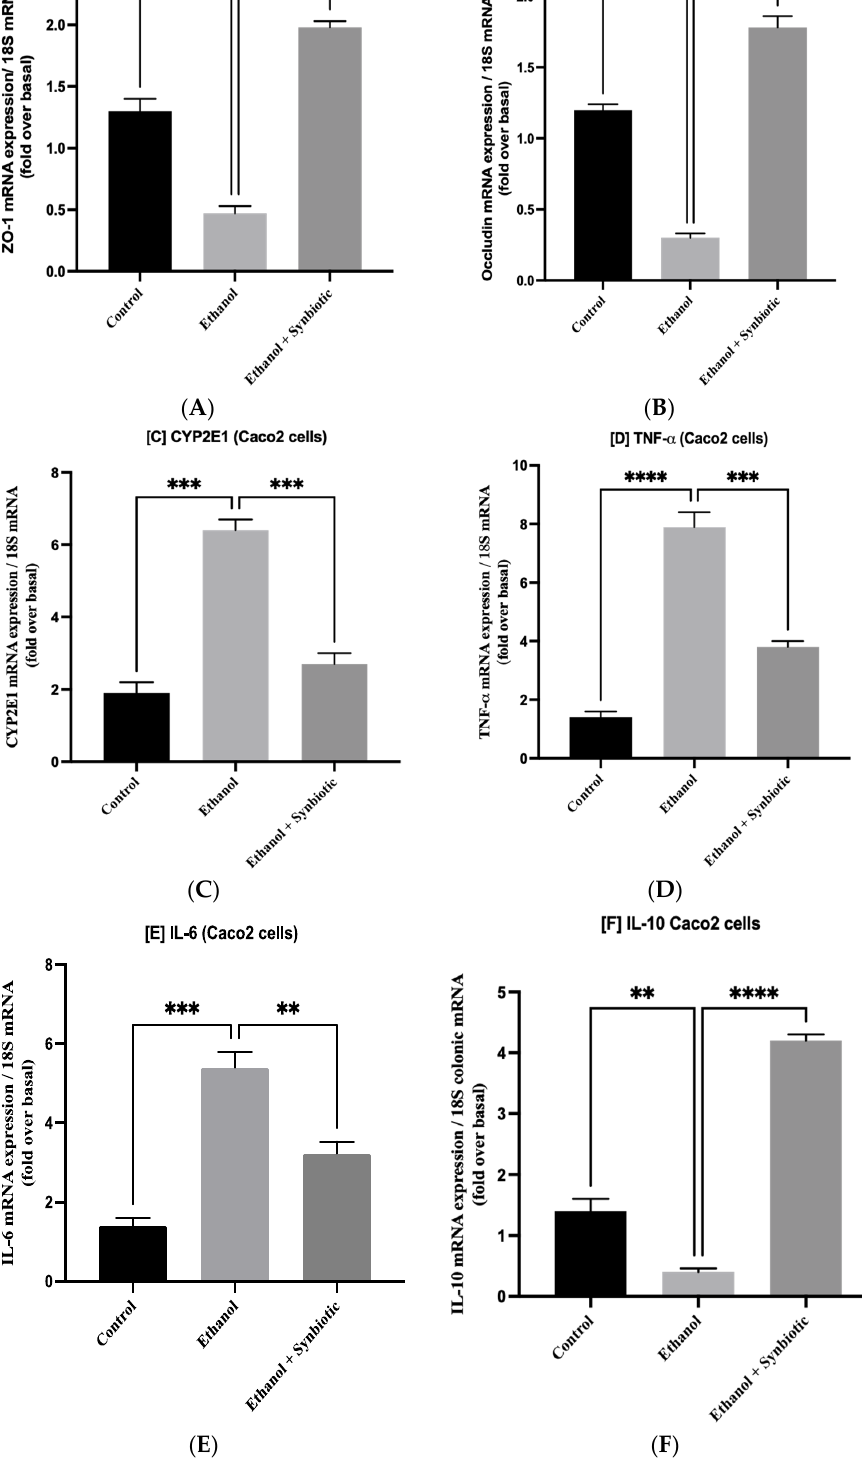
Figure 2. The effects of AGE and synbiotic on Caco-2 cells treated with ethanol. Tight junctions ( A ) ZO-1 and ( B ) occludin mRNA expression, as well as presentation of markers of inflammation ( C ) TNF-a, ( D ) CYP2E1, ( E ) IL-6, and anti-inflammatory indicator ( F ) IL-10, are all reported. The statistical analysis was calculated as mentioned in Section 2.11. Mean − /+ SD was determined for N = 6 replicates. For statistical analysis, GraphPad Prism 7 and one-way ANOVA in conjunction with the Tukey post hoc test were calculated. When associated with the ethanol group, significance ( p -value) is defined as ** p < 0.01, *** p < 0.001, **** p < 0.0001. TEER Analysis